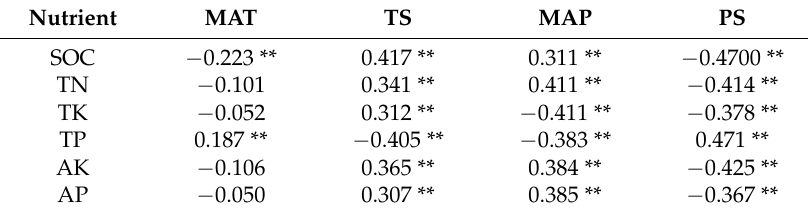
Table 2. Correlation coefficient matrix for soil nutrients and climatic factors. Nutrient MAT